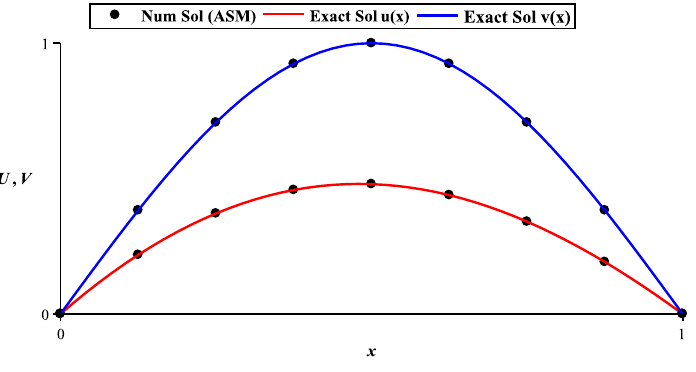
Figure 1. Numerical solution of Example 1 using (SCA) and N = 8 on uniform mesh. Example 2